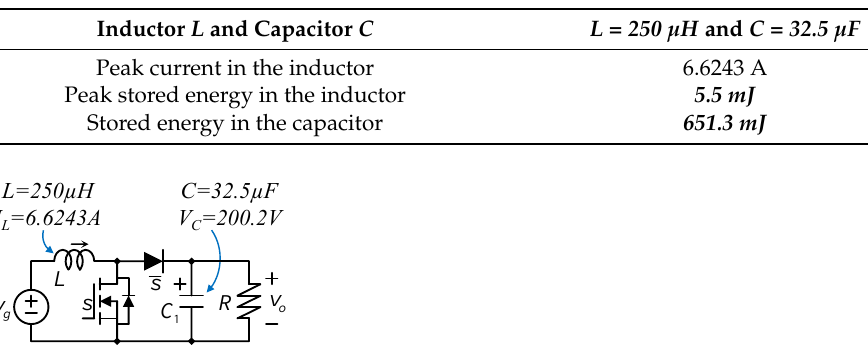
Figure 11. Result of the design with the traditional boost